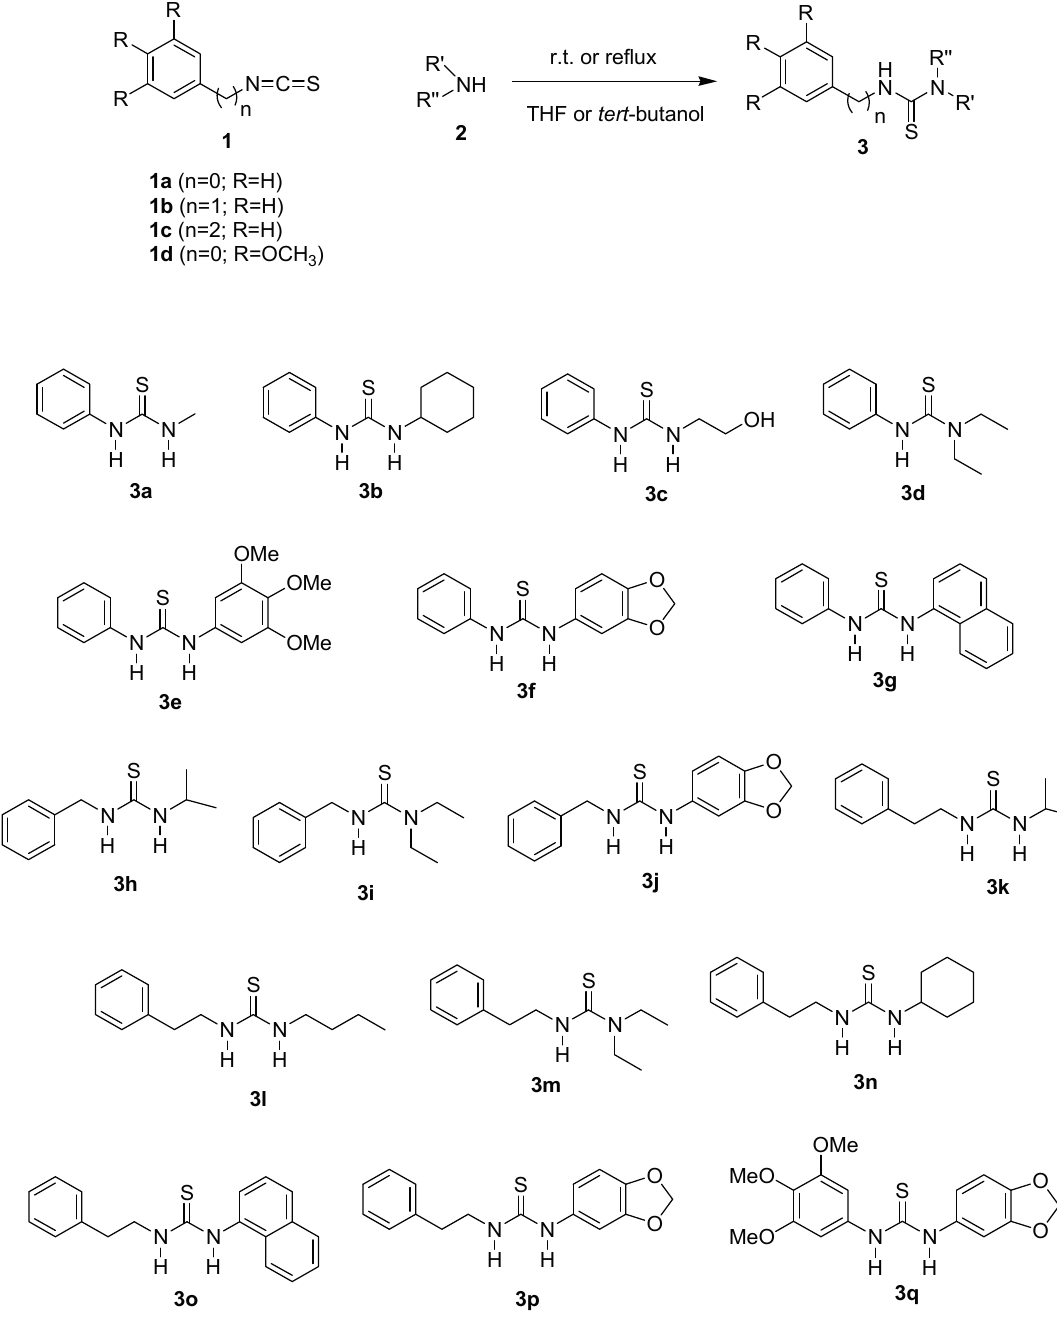
Scheme 1. Synthesis of thiourea derivatives from